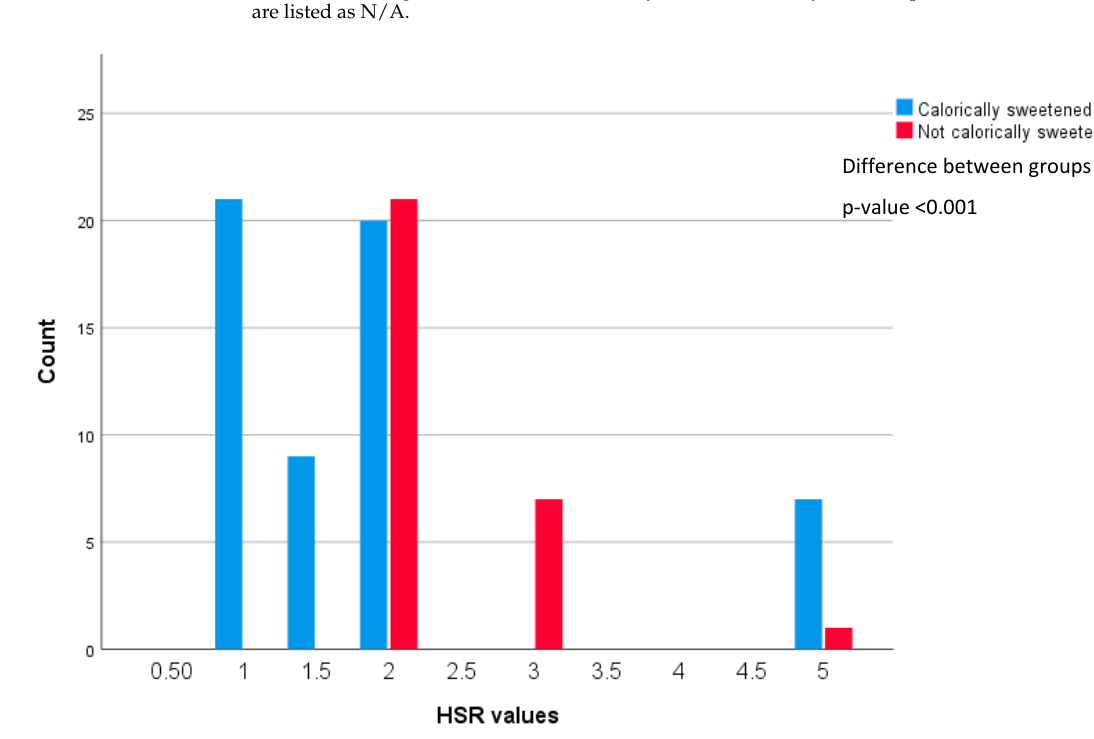
Figure 1. Distribution of HSR values displayed on sweetened or flavoured beverages in Australia.